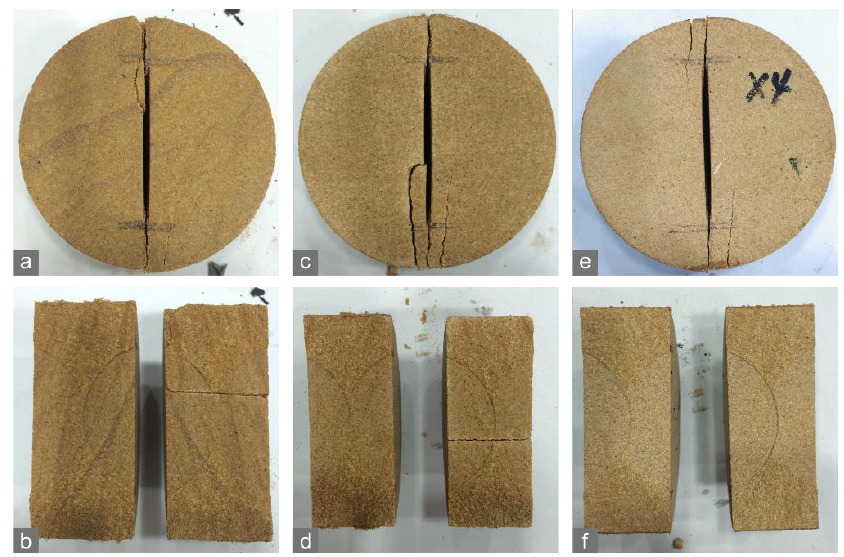
Figure 7. Crack morphologies of the sandstone specimens in the CCNBD tests at ( a , b ) 25 °C, ( c , d ) 75 °C, and ( e , f ) 125 °C.